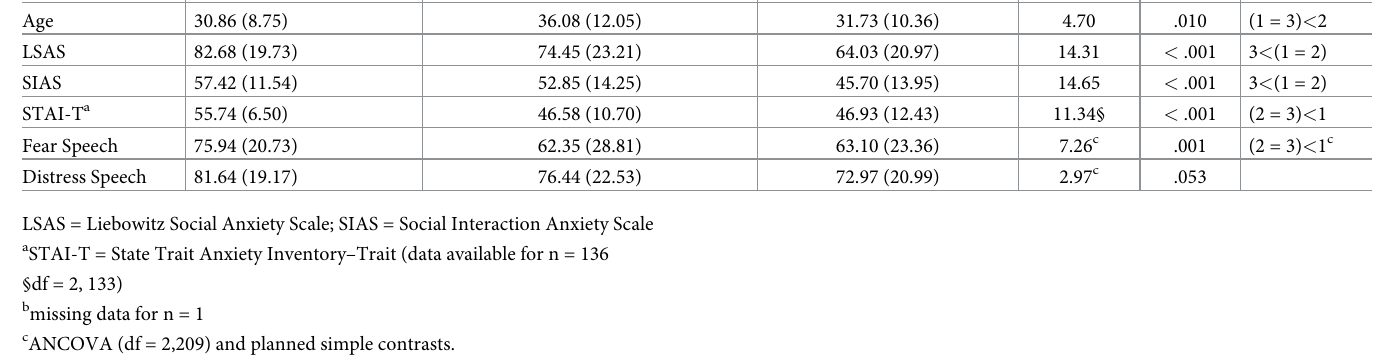
SAD ( χ 2 = 8.70, df = 1, p = .003, n = 72) and avoidant personality disorder ( χ 2 = 19.42, df = 1, p < .001, n = 73) were more common in the Prototypical cluster than in the remainder of SAD patients. The percentages of generalized SAD/avoidant personality disorder in the three clus- ters were: 88/83% for Prototypical , 69/38% for Introvert-Conscientious , and 46/25% for Insta- ble - Open SAD.